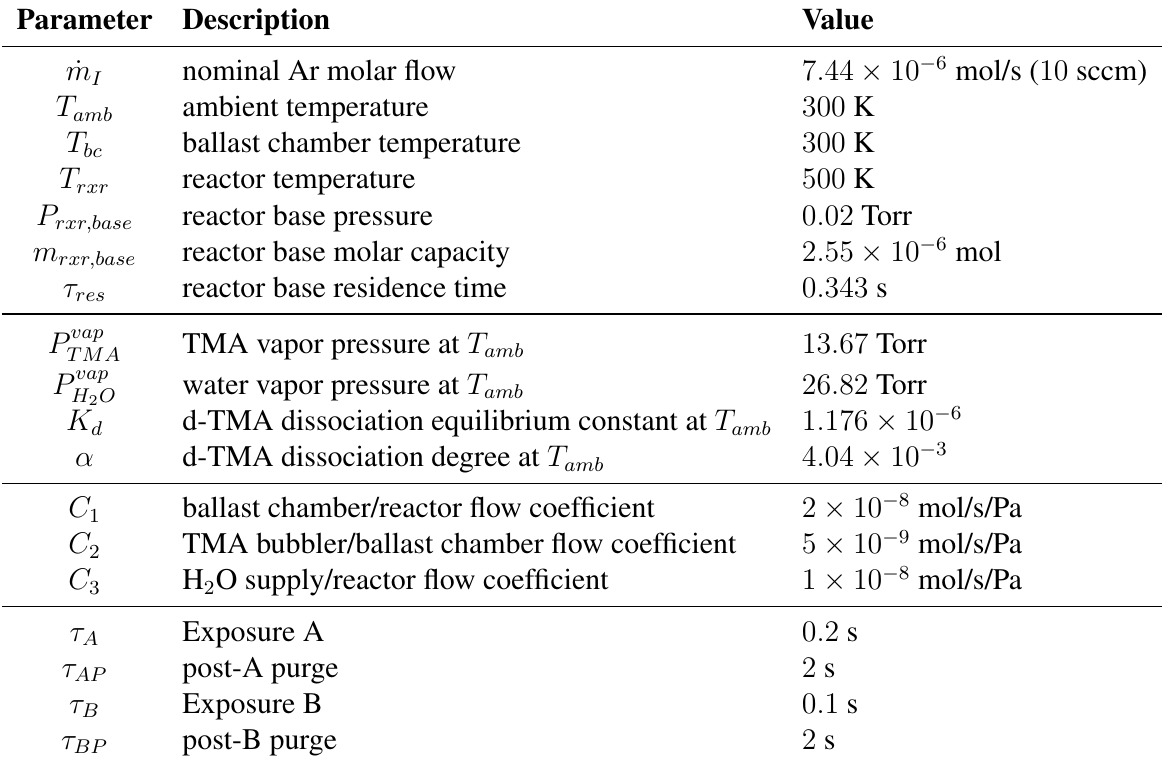
Table 2. Nominal ALD reactor conditions. d-TMA, dimer of